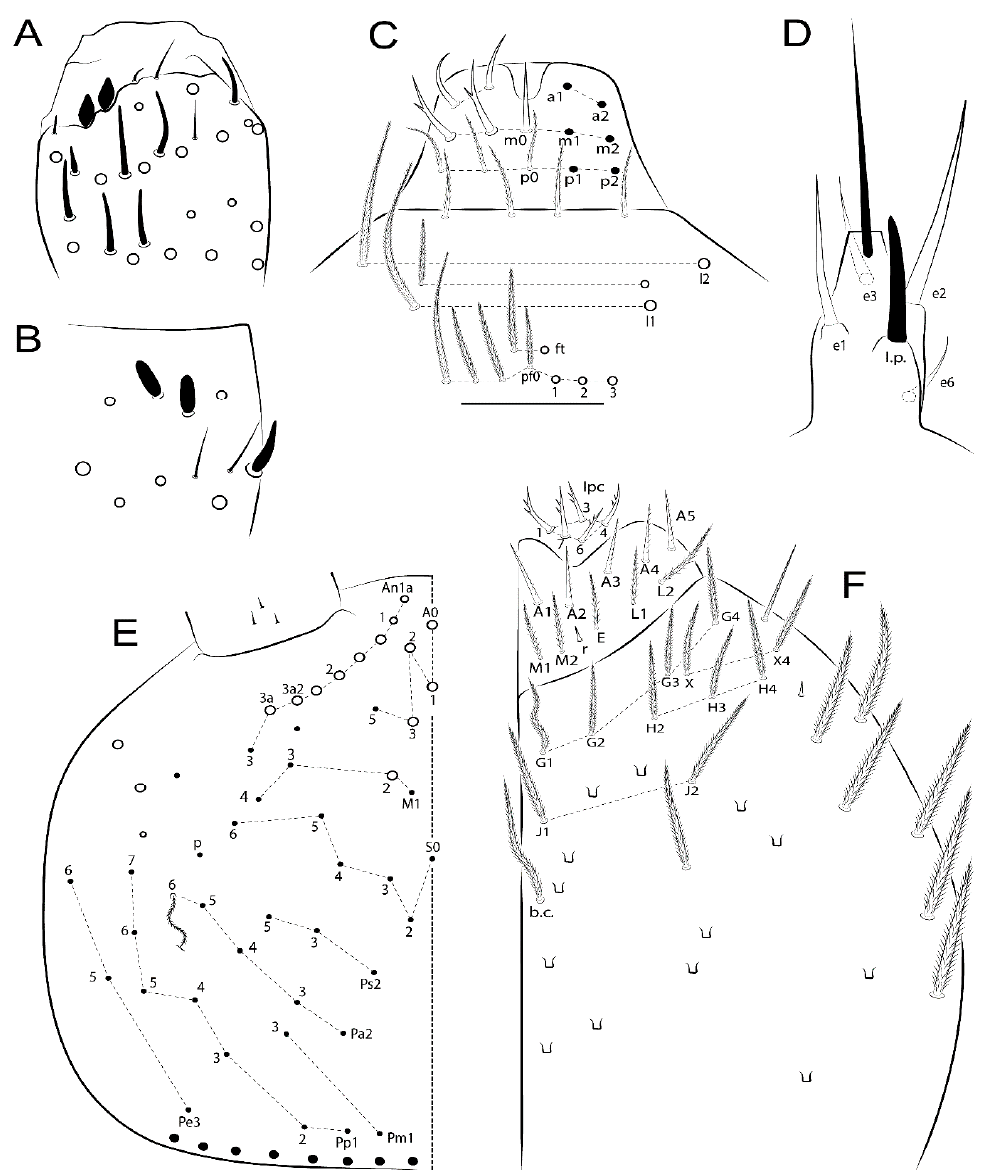
Figure 28. Pseudosinella serpentinensis sp. nov.: head. ( A ) Ant III apical organ (lateral view); ( B ) Ant II distal part (dorsal view); ( C ) chaetotaxy of clypeus, prelabrum, and labrum; ( D ) labial papilla E (right side); ( E ) head dorsal chaetotaxy (left side); ( F ) labial proximal chaetae, basomedian and basolateral labial fields, and complete postlabial chaetotaxy (right side).